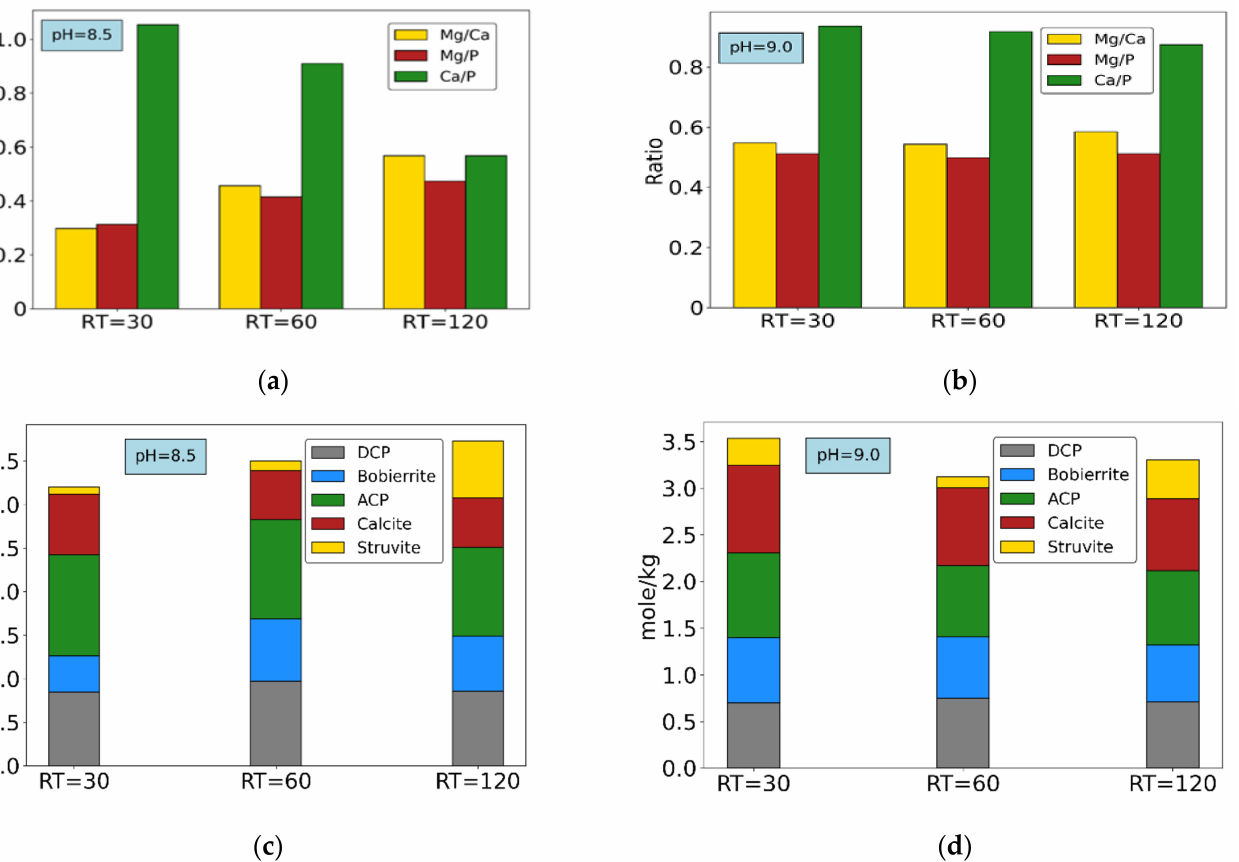
Figure 8. Molar ratios of main components: ( a ) pH = 8.5. ( b ) pH = 9.0; final precipitates’ composition: ( c ) pH = 8.5 and ( d ) pH = 9.0. Experiments